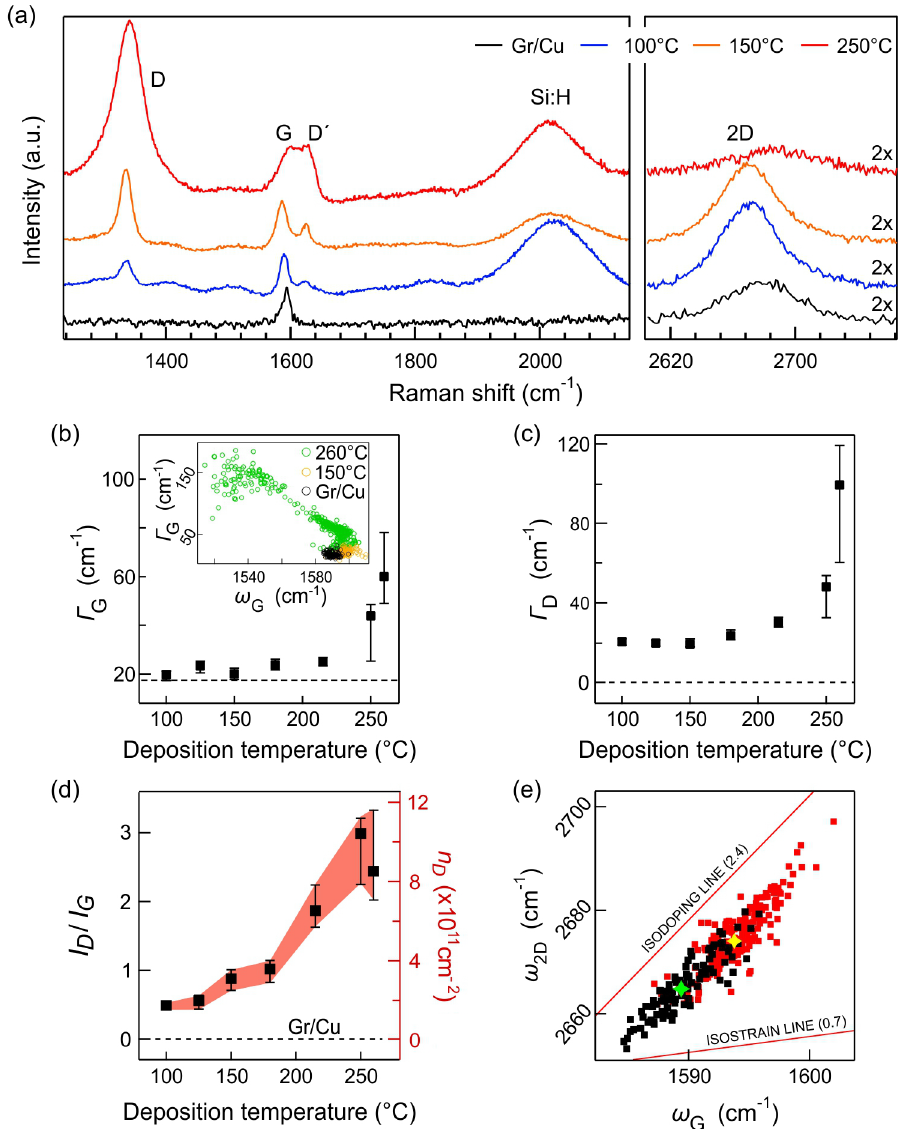
Figure 1. ( a ) Selected Raman spectra of as-grown graphene on the copper catalyst (black) and graphene with a-Si:H grown by plasma-enhanced chemical vapor deposition (PECVD) with deposition temperature in the range from 100 ◦ C to 260 ◦ C (colored). Raman 2D bands are multiplied 2 × for clarity. Spectra are normalized on the Raman G band of graphene. ( b , c ) Evolution of Γ G and Γ D , respectively, with increasing a-Si:H deposition temperatures. Inset in (b) shows correlation of Γ G with ω G for selected deposition temperatures. ( d ) I D / I G intensity ratios for increasing deposition temperature. Red-filled area indicates the estimated defect density according to Equation (1) (right axis). The spread of n D values is determined from the experimental error and the uncertainty from Equation (1). Horizontal dashed lines in (b–d) represent Γ G , Γ D , and I D / I G median values for as-grown graphene; zero medians denote absence of the D band in the spectra. The data points in the main panels b–d represent medians of the fitted values from Raman maps comprising at least 225 points; the error bars are the first and third quartiles of the data distributions. ( e ) Correlation plot of the G and 2D frequencies for all points obtained during Raman mapping of the as-grown graphene (black squares) and graphene with a-Si:H deposited at 100 ◦ C (red squares). Green and yellow asterisks mark medians of the